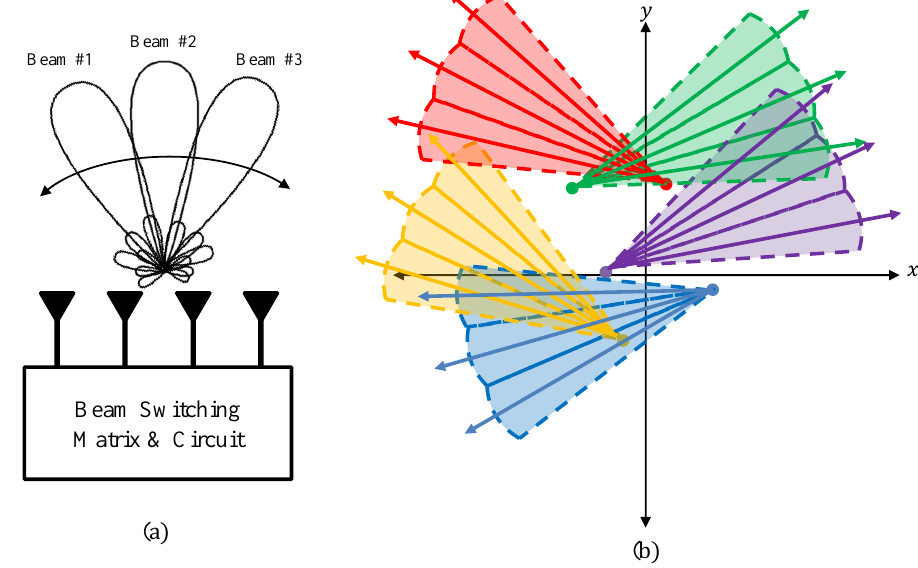
Figure 2. ( a ) The configuration of a beam-switching structure (BSS). ( b ) The beampatterns of sensors (colored dots) having